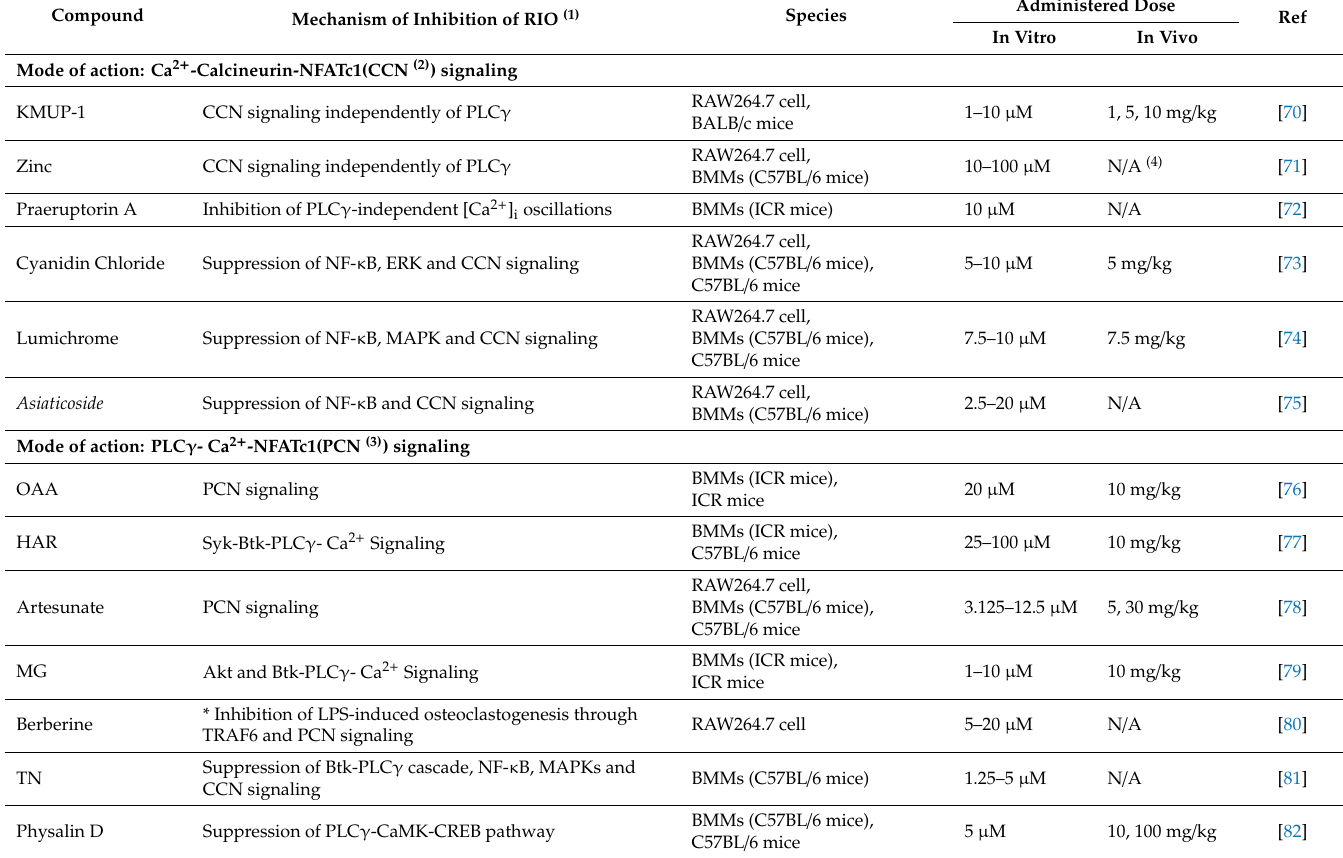
Table 1. Diverse compounds that regulate Ca 2 + signaling in